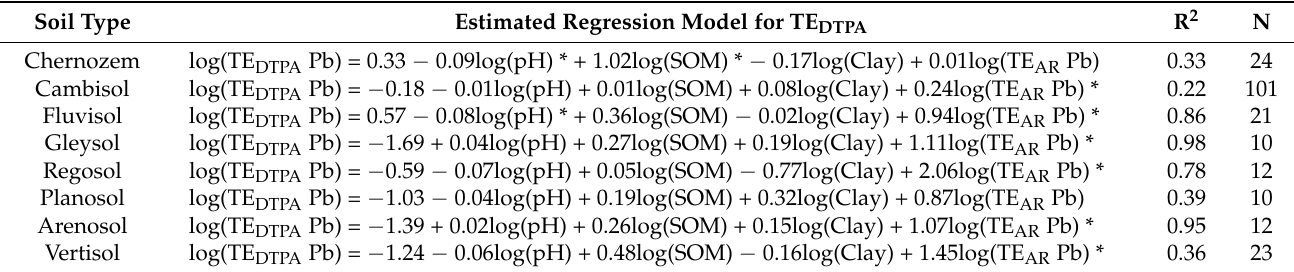
Table 10. Prediction model 7.